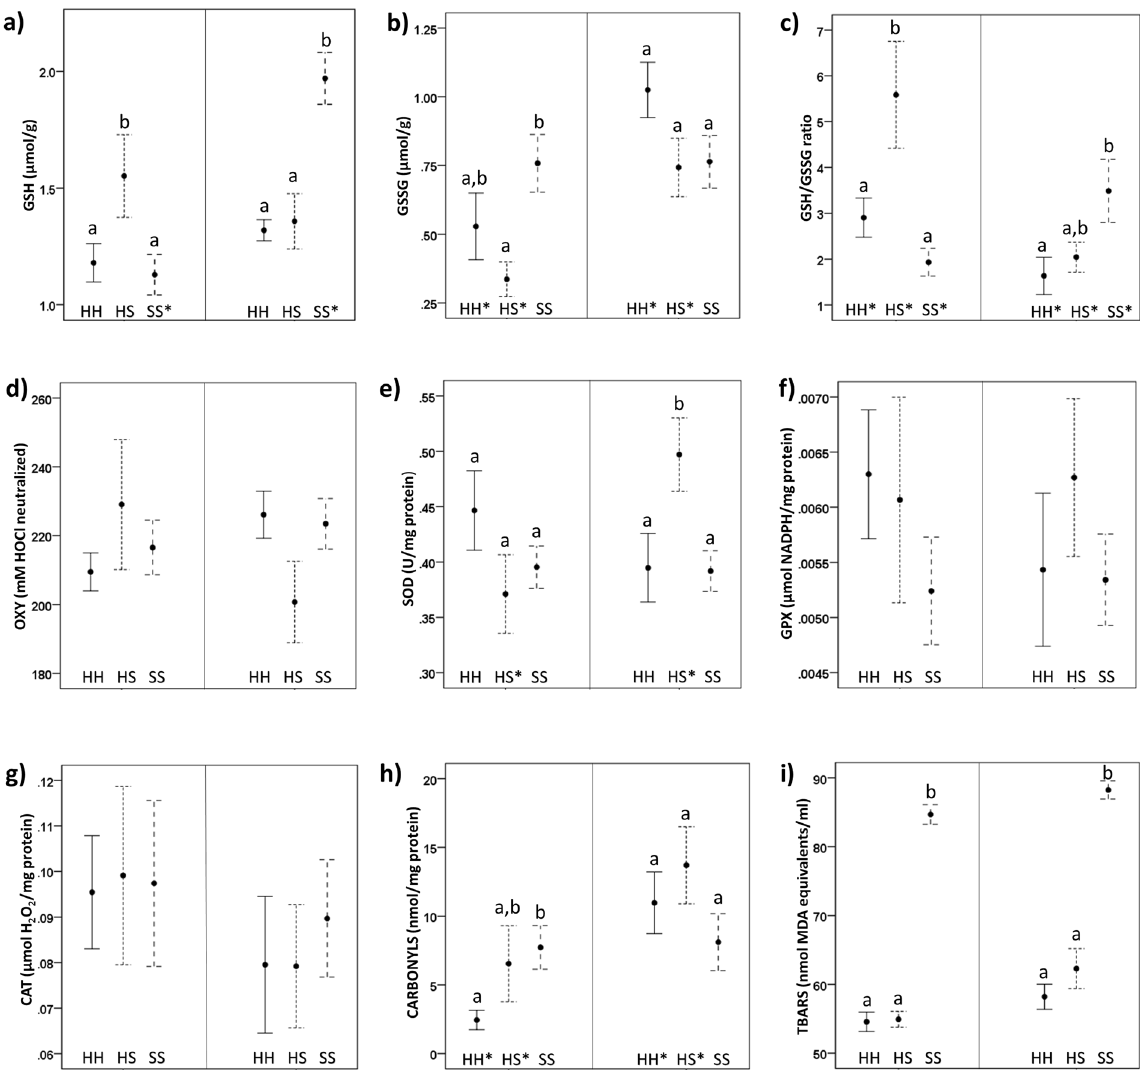
Figure 2. Mean and standard error of the biomarkers of OS. Different groups are indicated on the x axis by the acronyms “HH” (n = 11), “HS” (n = 6), and “SS” (n = 14). After post-hoc comparisons on the GSH, GSSG, GSH/GSSG, SOD, CARBONYLS, and TBARS models, plots which share the same letter showed no significant differences within the first period (left panel), or the second sampling period (right panel). Groups with an asterisk next to their acronym had a significant increase or decrease from the first to the second